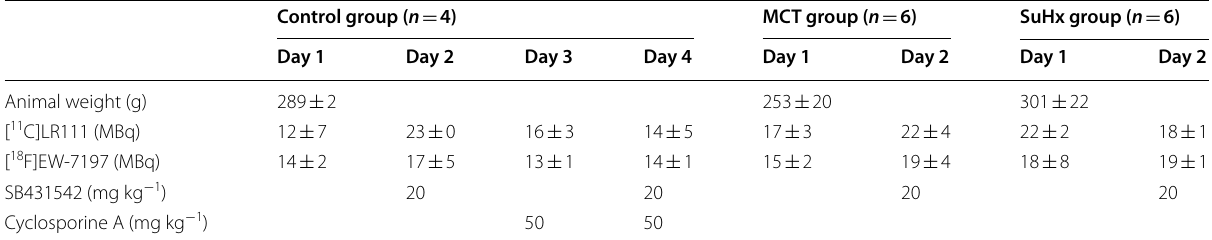
Table 1 Injected doses of [ 18 F]EW-7197, [ 11 C]LR111, SB431542, cyclosporine and animal weights of each experimental